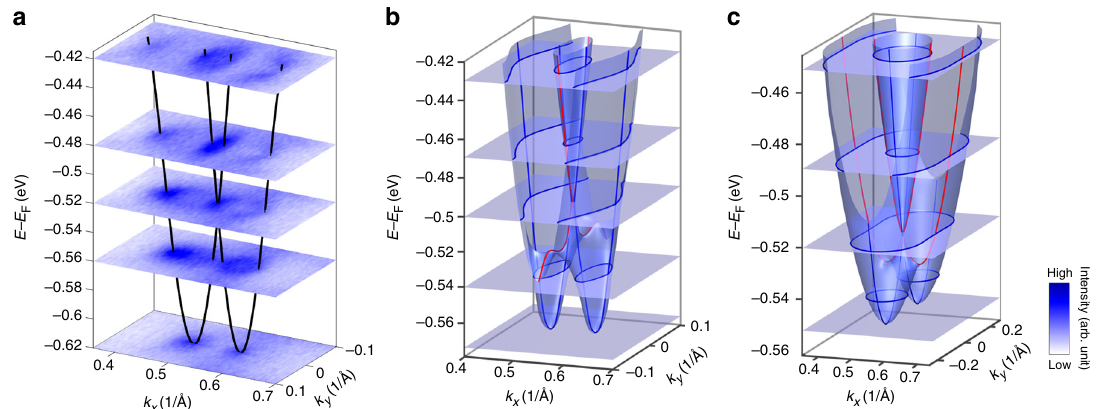
Fig. 4 3D electronic structure of the Rashba-like splitting. a 3D E ( k x , k y ) map from angle-resolved photoemission spectroscopy (ARPES) data ( h ν = 9 eV). The black lines indicate the Rashba-split bands. Different surfaces correspond to constant-energy contours at different binding energies. b Calculated 3D electronic structure of PtBi 2 at the M point. The red lines indicate the Rashba-split dispersion along M – K ( k y ) direction, while the blue lines indicate the Rashba-split dispersion along M – Γ ( k x ) direction. c Calculated 3D electronic structure considering only pure Rashba SOC, taking effective masses from the ARPES data. The blue lines indicate the Rashba-split dispersion along M – K ( k y ) direction, while the red lines indicate the Rashba-split dispersion along M – Γ ( k x ) direction. Both red (blue) lines in b , c indicate dispersions with smaller (larger) band splitting. The gray surfaces with blue lines on them in b , c sketch out the constant-energy contours at different binding